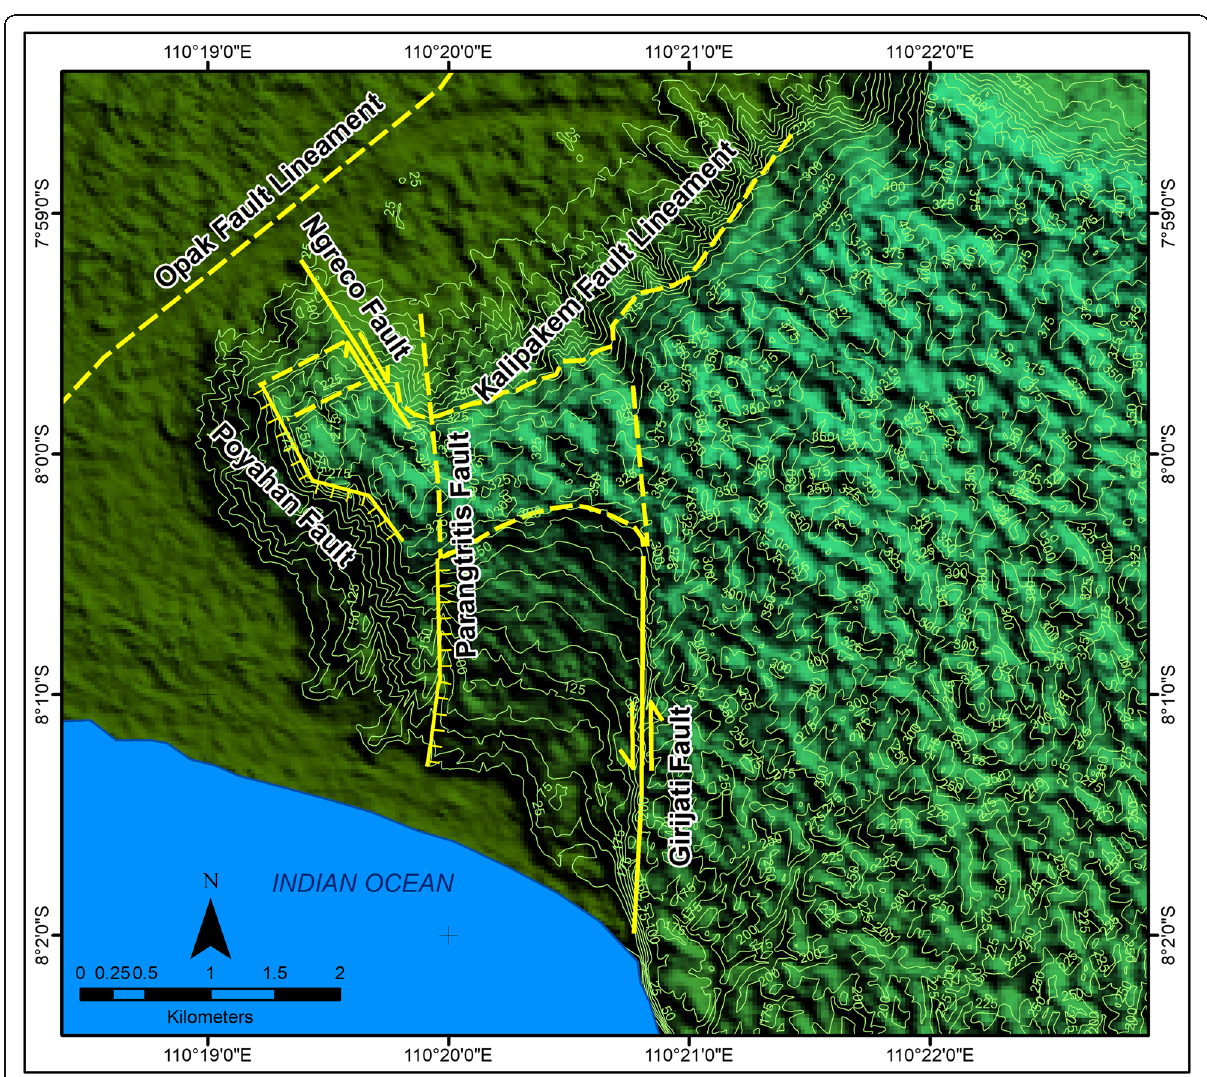
Fig. 3 Developed geological structures in the study area. Data used for the structure analysis was NASA Shuttle Radar Topography